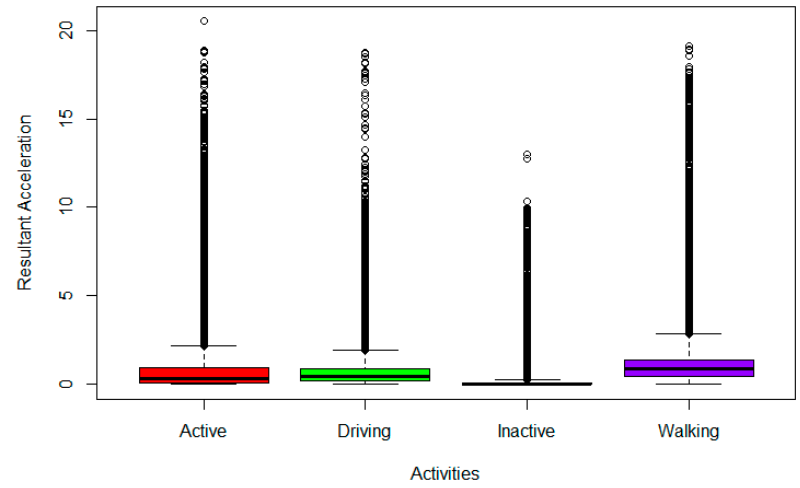
Figure 2. Detection of Outliers.